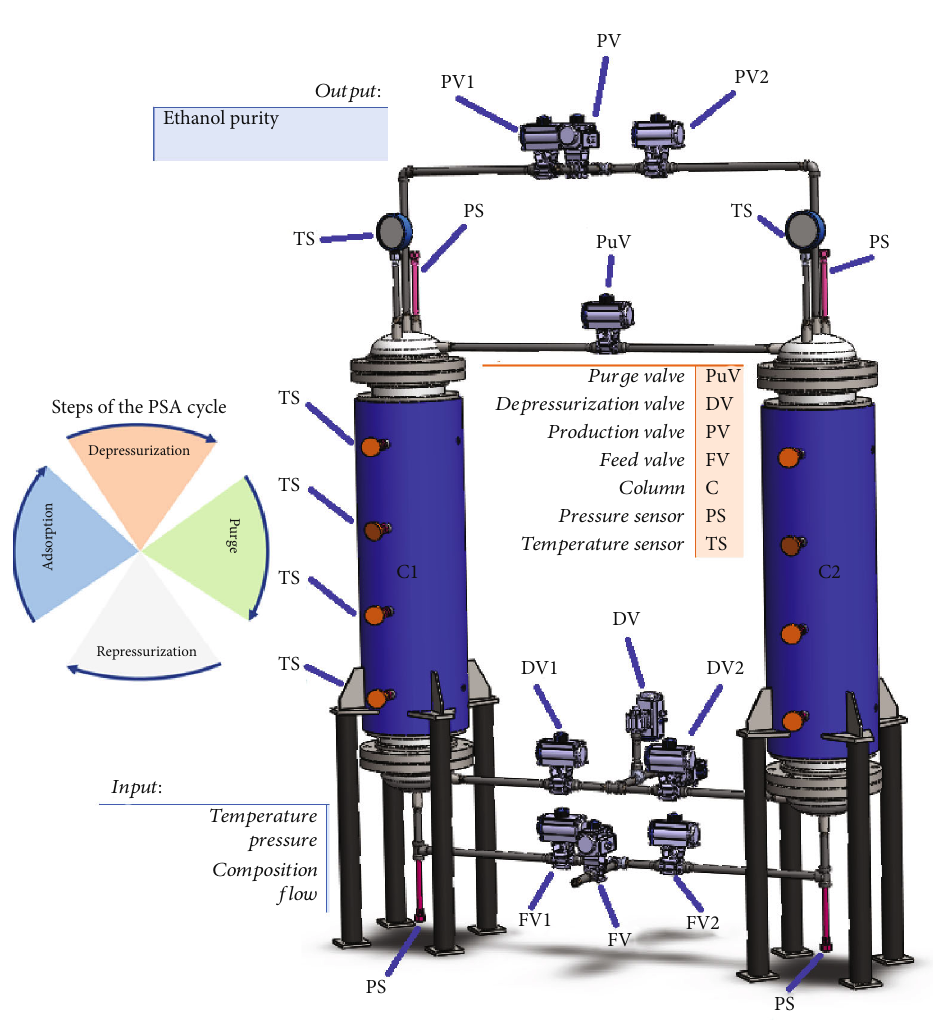
Figure 1: Schematic diagram of the PSA